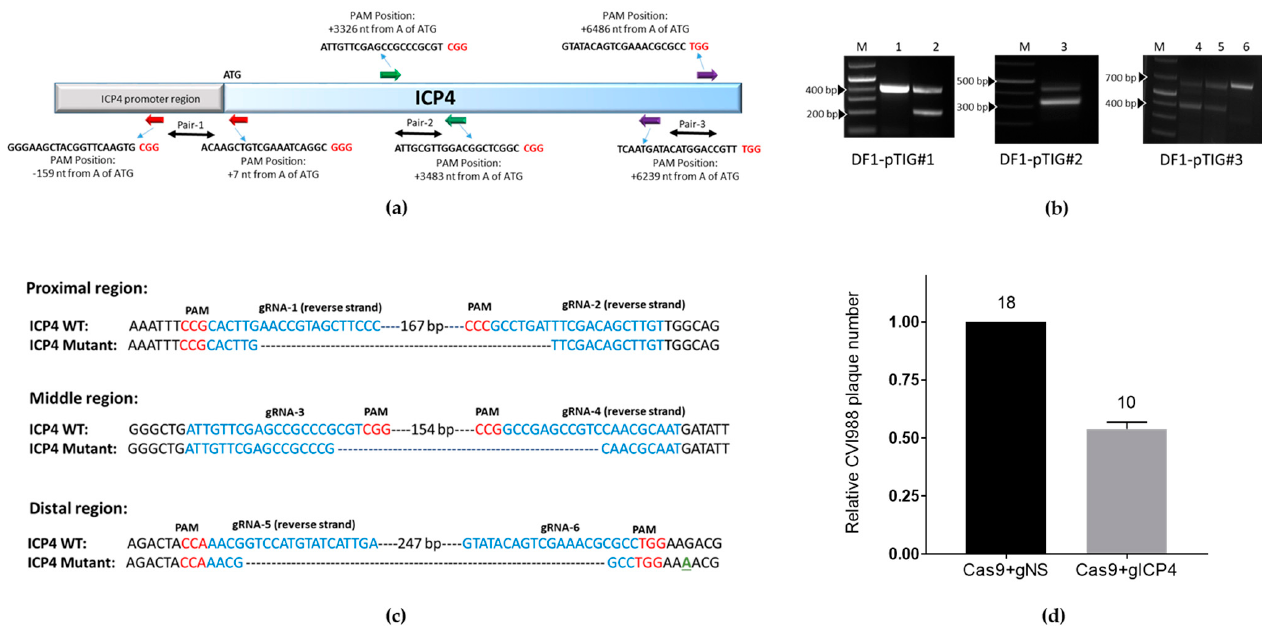
Figure 2. Design and characterization of the guide RNAs (gRNAs) targeting ICP4 gene. ( a ) Schematic representation of six gRNAs designed to target the ICP4 gene. The PAM sequence was highlighted in red color. ( b ) Assessment of gRNAs against ICP4. DF1-pTIG#1, DF1-pTIG#2 and DF1-pTIG#3 cells were co-transfected with GFP-gRNA and a pair of ICP4-gRNAs in pX333 or an empty pX333 vector. Agarose gel electrophoresis of PCR products amplified using primers spanning across the targeted regions, respectively. Expected PCR amplicons: proximal DF1-pTIG#1 (wild-type (WT): ~400 bp; mutant: ~210 bp), middle DF1-pTIG#2 (WT: ~480 bp; mutant: ~300 bp) and distal DF1-pTIG#3 (WT: ~650 bp; mutant: ~400 bp). Targeted deletion of proximal (lane 2), middle (lane 3) and distal regions (lane 4 and 5) of ICP4 gene fragments in pTIG cells by corresponding ICP4 gRNAs in pX333 vector. Lanes 1 and 6, control DF1-pTIG#1 and DF1-pTIG#3 cells, respectively, transfected with empty pX333 vector. M, 1 kb + ladder. ( c ) Sequence comparison of WT and cleaved ICP4 PCR amplicons. The PAM is highlighted in red; the gRNA site is highlighted in blue and a base change is highlighted in green. ( d ) Effect of ICP4-gRNAs on MDV replication. Chicken embryo fibroblasts (CEF) were transfected with vectors carrying the Cas9 and ICP4 gRNAs (gICP4) or non-specific gRNAS (gNS) and infected with CVI988 MDV. Plaques were counted after four passages. The numbers of plaque-forming units (PFU) (on top of each column) for the cells transfected with ICP4-gRNAs (grey bar) are the average of two separate experiments and shown as the fraction of the PFU count for NS gRNAs (black bar), which is set at